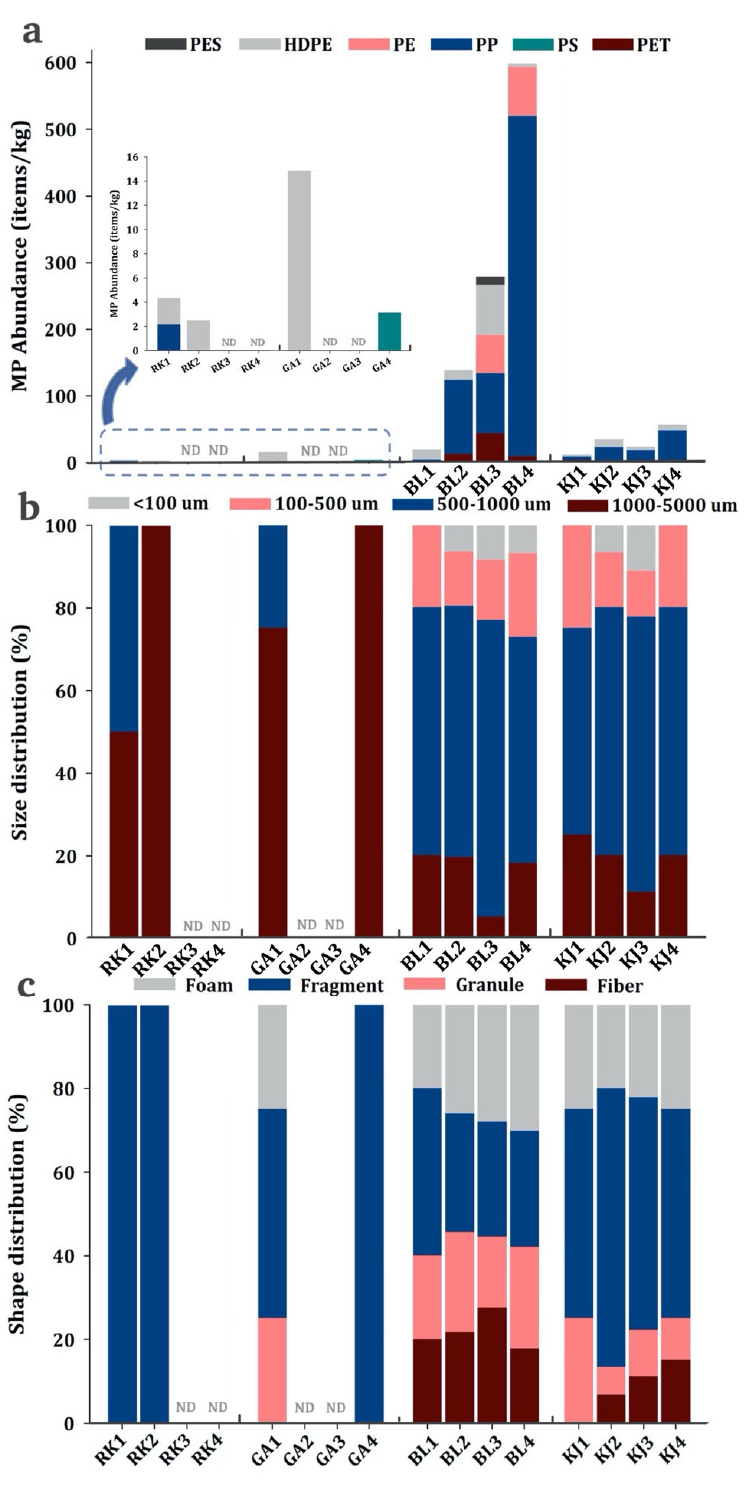
Figure 2. Distribution of MP ( a ) compositions, ( b ) sizes, and ( c ) shapes at sampling stations. Based on the µ -FTIR analysis results, six components of MPs were identified in the sediments of East Surabaya: polyester (PES, 1.27 g/cm 3 ), high-density polyethylene (HDPE, 0.96 g/cm 3 ), poly-ethylene (PE, 0.93 g/cm 3 ), polypropylene (PP, 0.905 g/cm 3 ), polystyrene (PS, 1.05 g/cm 3 ), and polyethylene terephthalate (PET, 1.29 g/cm 3 ). PP was the dominant component, accounting for 70.1%, followed by HDPE (11.9%), PE (11.5%), PET